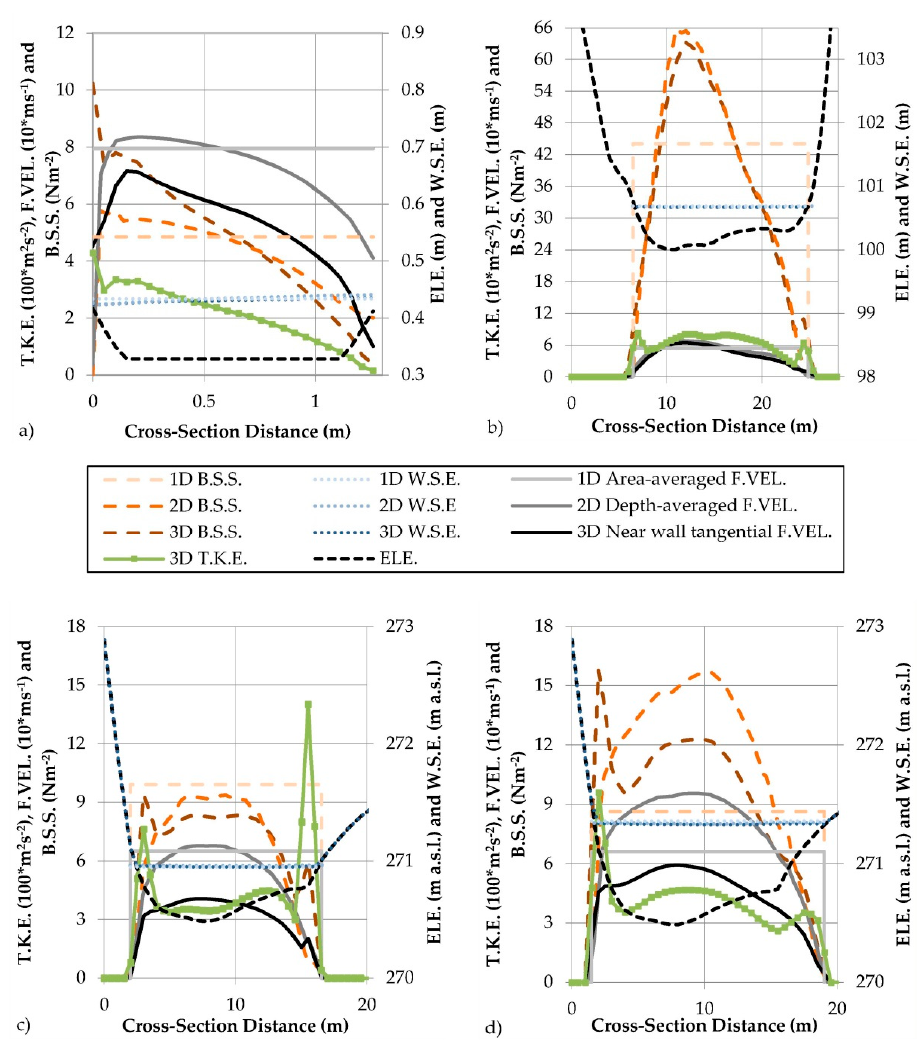
Figure 6. Detailed analysis of the hydrodynamics simulated by the 1D, 2D and 3D models in ( a ) CS 49 of C.1, ( b ) CS 28 of C.2 at Q M , ( c ) CS 17 of C.3 at Q L and ( d ) CS 17 of C.3 at Q M including water surface elevations (blue dotted lines), bed shear stresses (brown large-spaced dashed lines), various flow velocities (area-averaged flow velocities (grey lines), depth-averaged flow velocities (dark grey lines), near wall tangential flow velocities (black lines)) and turbulent kinetic energies (green lines with rectangles) as well as bed elevations (black small-spaced dashed lines).